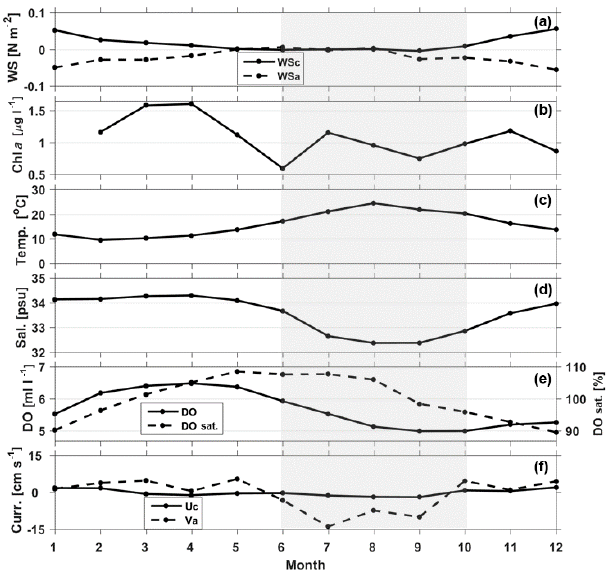
Figure 3. Climatology for (a) alongshore and cross-shore compo- nents of wind stress, (b) chlorophyll fluorescence, (c) water temper- ature, (d) salinity, (e) dissolved oxygen in both mLL − 1 and percent saturation, and (f) alongshore and cross-shore components of sur- face ( ∼ 5m) current constructed using ESROB data collected in 3 years from 2011 to 2013. Summer season (JJAS) is shaded.